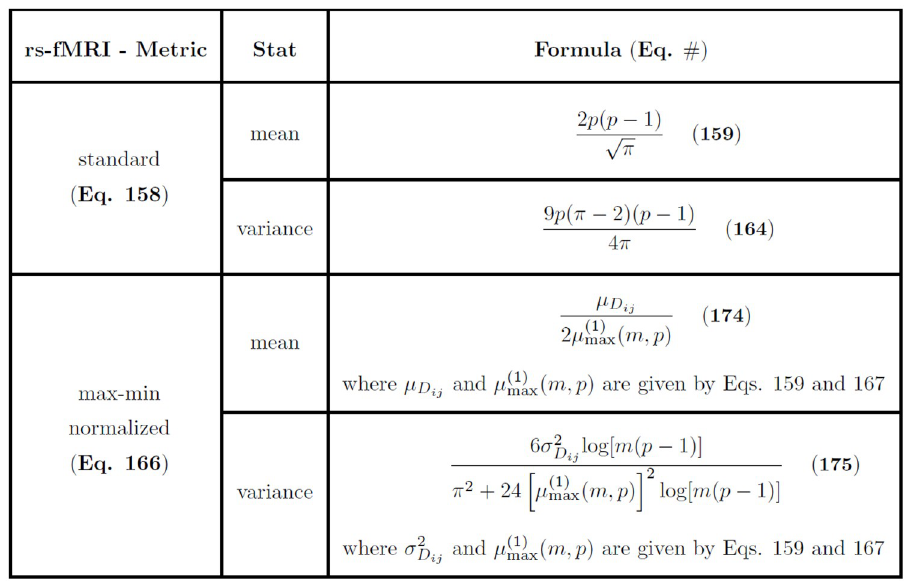
Fig 10. Aymptotic means and variances for the new standard (Eq 158) and max-min normalized (Eq 166) rs-fMRI distance